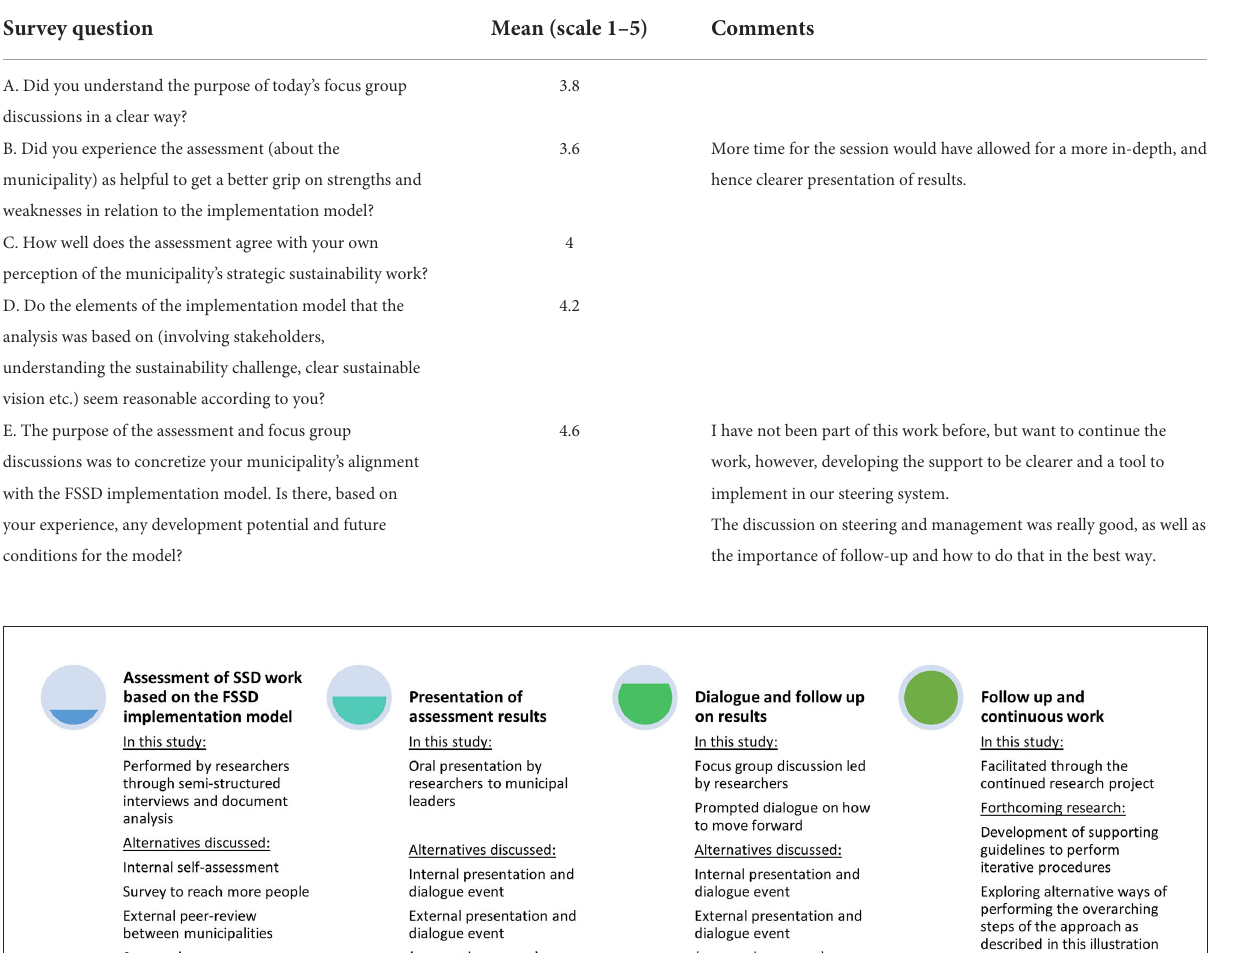
TABLE 1 Survey results from evaluating the designed and tested